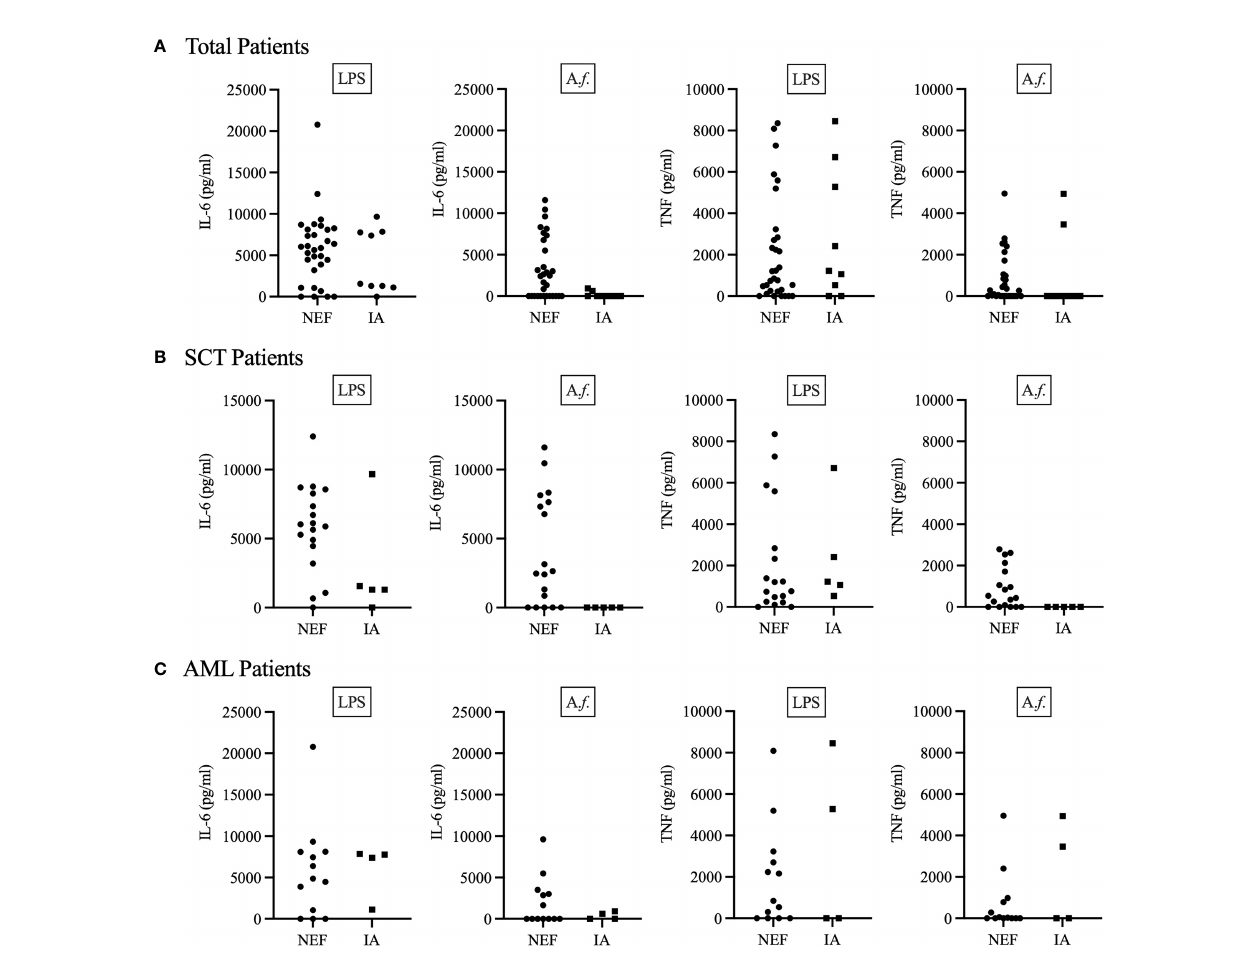
FIGURE 2 | IA patients may lack a speci fi c anti- Aspergillus TNF and IL-6 cytokine response. Patient PBMCs were isolated from whole blood and stimulated with 1 m g/ml LPS or 5x10 6 Aspergillus fumigatus RC/ml for 24 h. (A) Displays total patient results, (B) displays SCT patient results and (C) displays AML patient results. 24 h after stimulation, supernatant was collected, and the concentration of TNF and IL-6 determined by ELISA. IA represents probable IA. NEF represents no evidence of fungal disease. Statistical analysis for these graphs is presented in Table 3 . Data from these graphs are the same as in (A) from a previous publication from our group